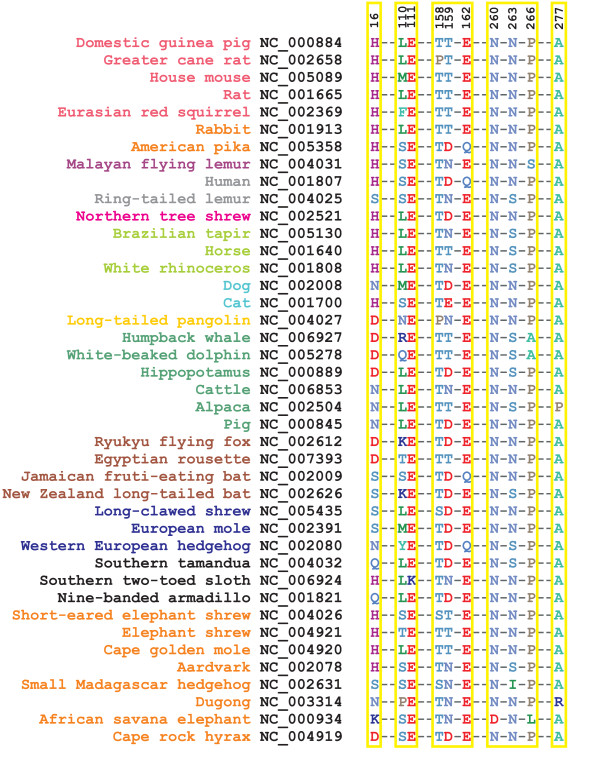
Amino acid variation in functional sites of mammalian cytochrome b. Amino acid variation in the selected sites of CytB presented in Figure 9 across all the mammalian species surveyed in this study.